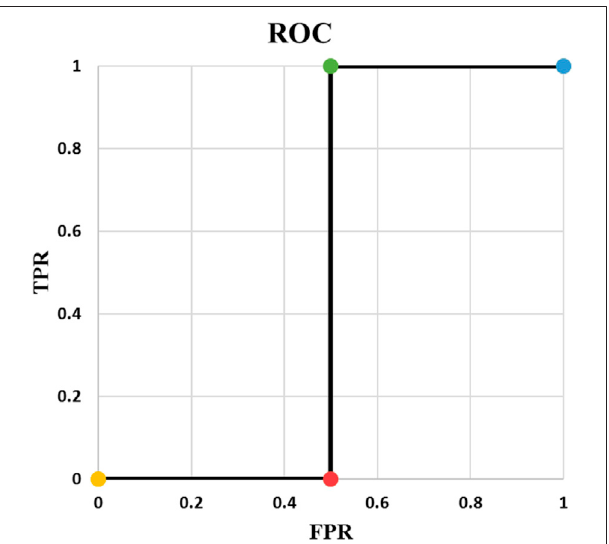
FIGURE 4 | ROC of Example